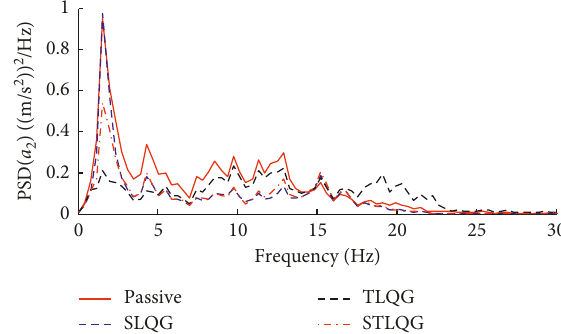
Figure 11: J - t curves under 25ms time delay.